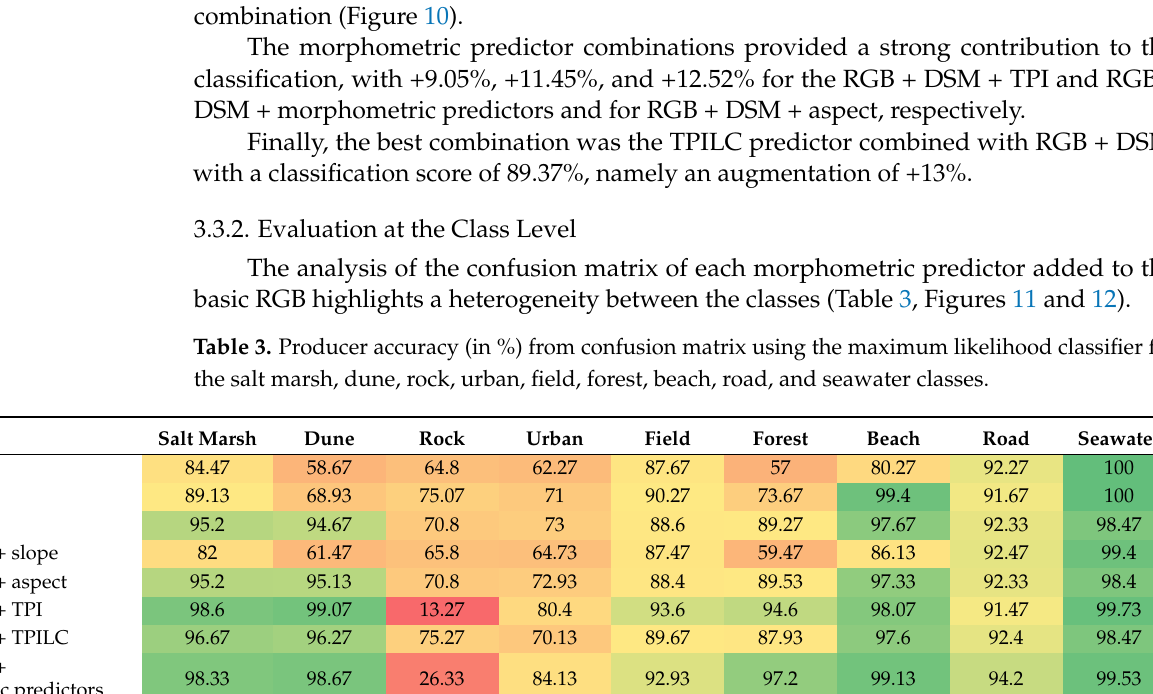
Figure 10. Overall accuracy of the eight classifications performed with the maximum likelihood classifier. The NIR band was also tested and obtained a score of 84.34% combined with the RGB. Thus, in addition to the RGB, the DSM significantly enhanced the OA by +12.51%,